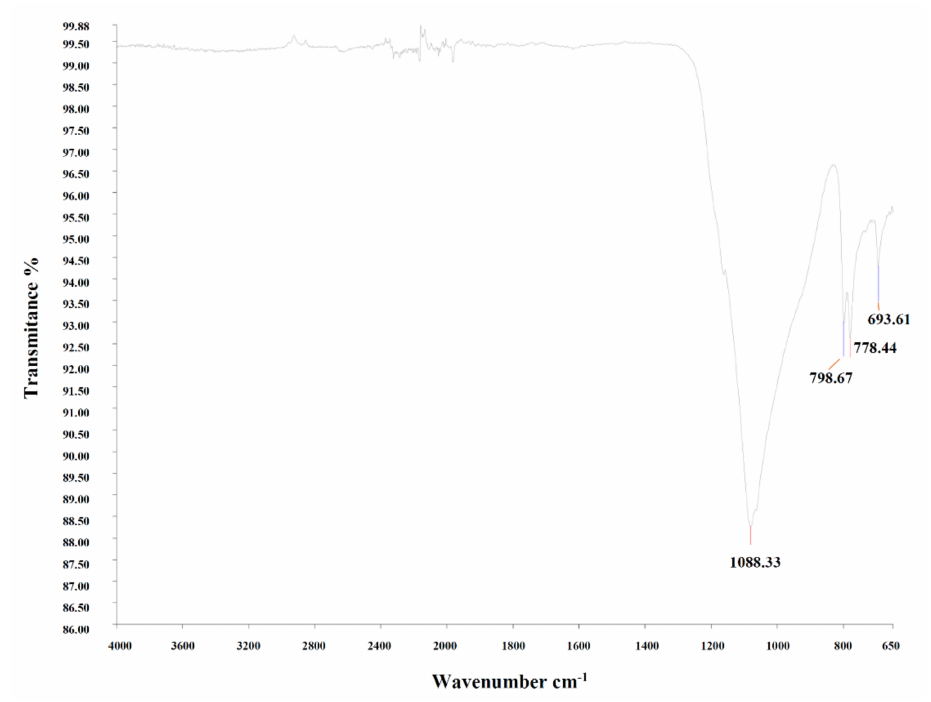
Figure 8. Fourier transform infrared spectra of WFES.